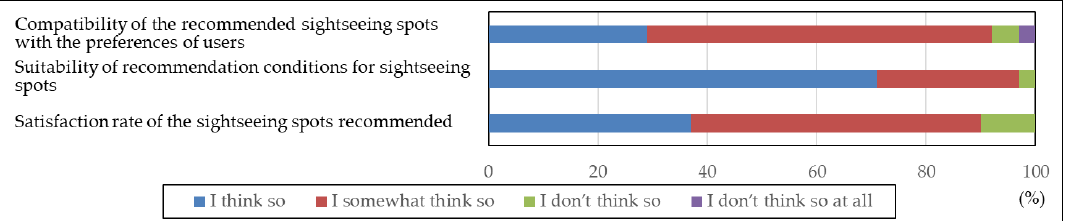
Figure 9. Evaluations concerning the recommendation function of sightseeing spots adopting knowledge-based recommendations.